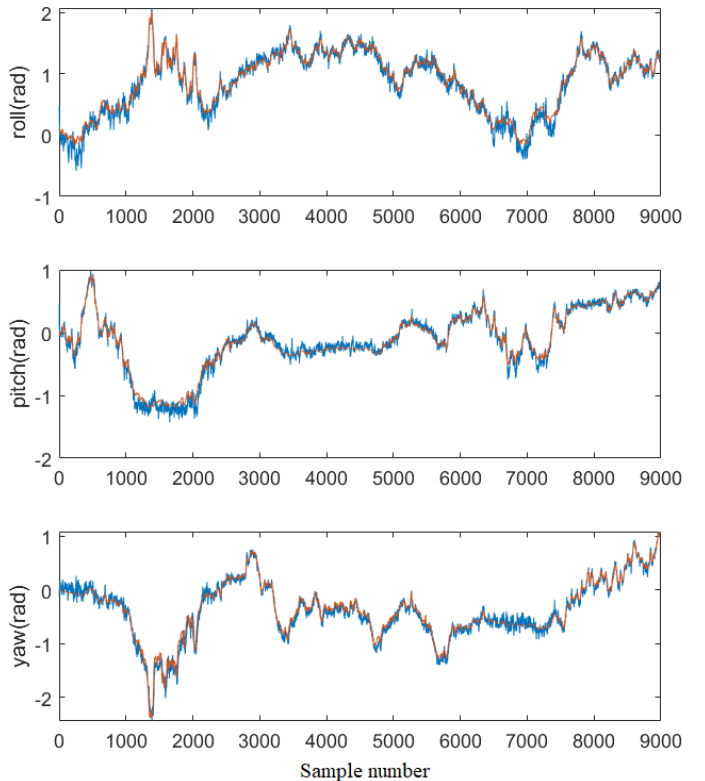
Figure 11. Estimated Euler angles of the LSTM test set: red line represents LSTM output; blue line represents sample